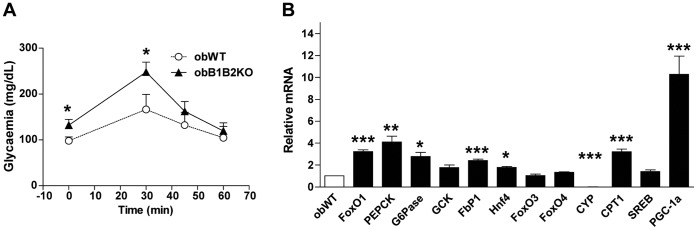
Increased gluconeogenesis and hepatic expression of FoxO1, PGC-1a and gluconeogenesis regulatory enzymes.The experiments were performed in 6-month-old mice. A) Pyruvate challenge proceeded by intraperitoneal injection of 0.5 g/kg pyruvate; B) Quantitative real time PCR: The results are expressed as changes relative to the control obWT group. Forkhead box protein O1, 03 and 04 (FoxO1, O3 and O4), phosphoenolpyruvate carboxykinase (PEPCK), glucose-6-phosphatase (G6Pase), glucokinase (GCK), fructose-1,6-bisphosphatase 1 (FbP1), hepatocyte nuclear factor 4 alpha (Hnf4), 25-hydroxycholesterol 7-alpha-hydroxylase (CYP), carnitine palmitoyltransferase-1 (CPT1), Sterol regulatory element-binding protein 1 (SREB), peroxisome proliferator-activated receptor gamma coactivator 1-alpha (PGC-1a). Data are presented as the means ± SEM. Student’s t-test: *, p<0.05; **, p<0.01; ***, p<0.001; n = 5.